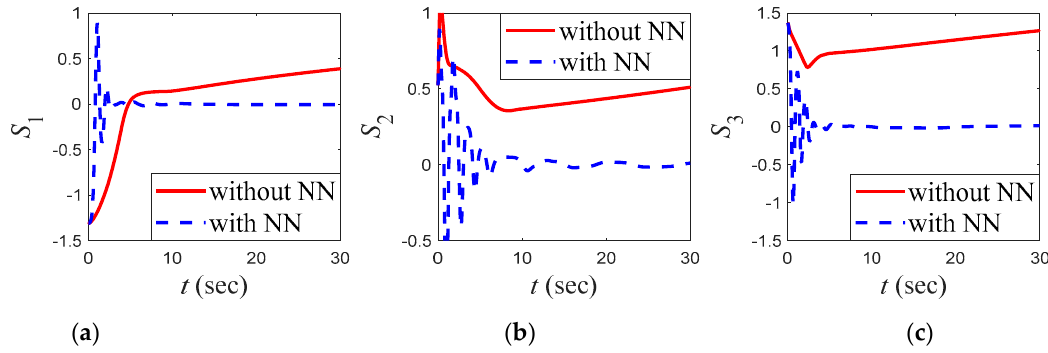
Figure 16. Comparison of sliding manifolds under control laws with or without NN. ( a ) The first value of the sliding manifold; ( b ) The second value of the sliding manifold; ( c ) The third value of the sliding manifold.